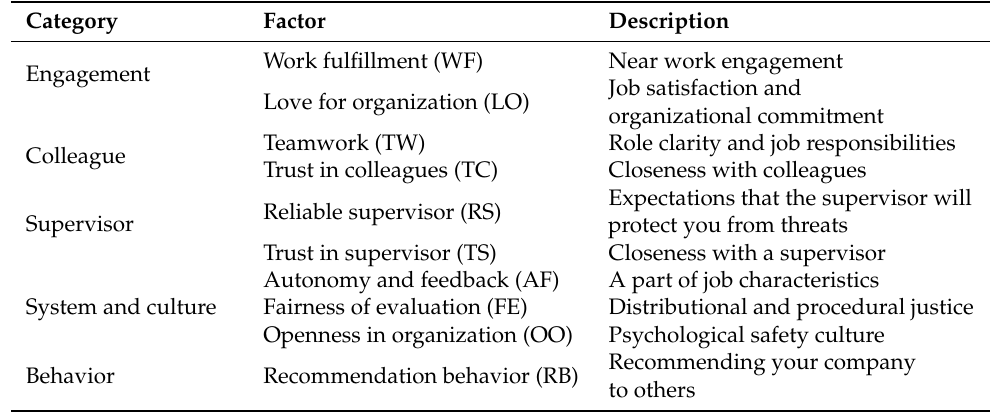
Table 1. The 10 factors in our